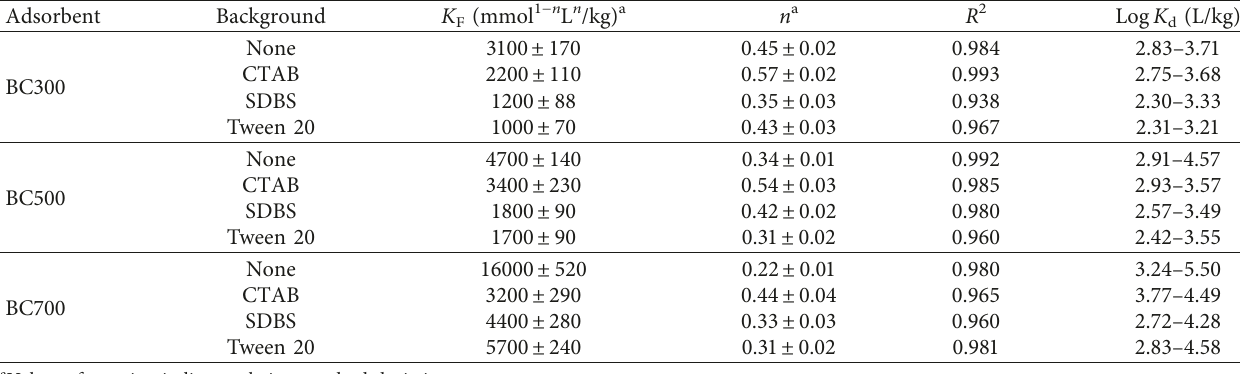
Table 4: Summary of adsorption parameters (Freundlich model coefficients ( K adsorption results.